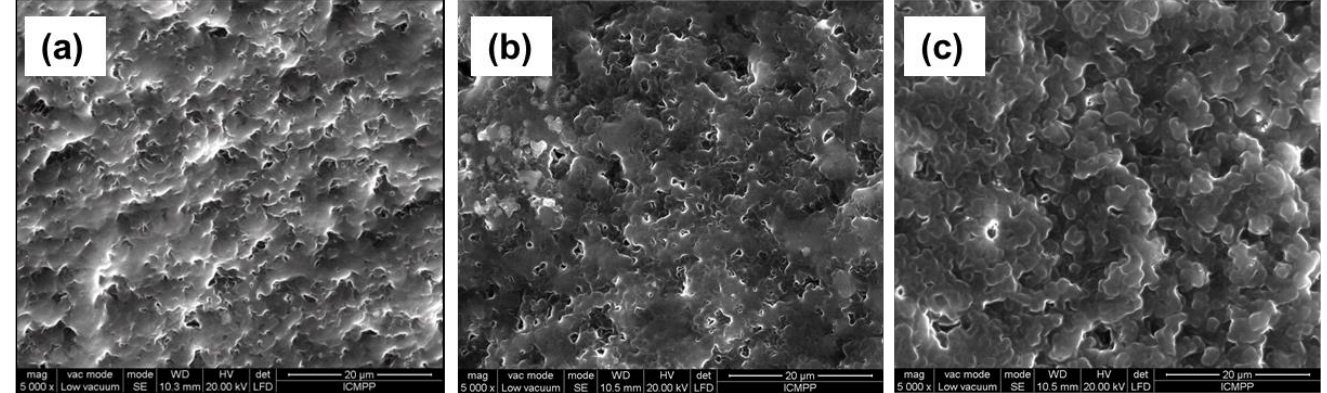
Figure 4. Influence of the cross-linker on the surface morphology of PHEMA/P4VP: ( a ) EGDMA; ( b ) DEGDMA; ( c ) TEGDMA, (solvent of P4VP = ethanol:sodium bicarbonate (40:60, v / v ), HEMA:cross-linker = 1:50, mol/mol, HEMA:P4VP = 1:0.2 g/g).